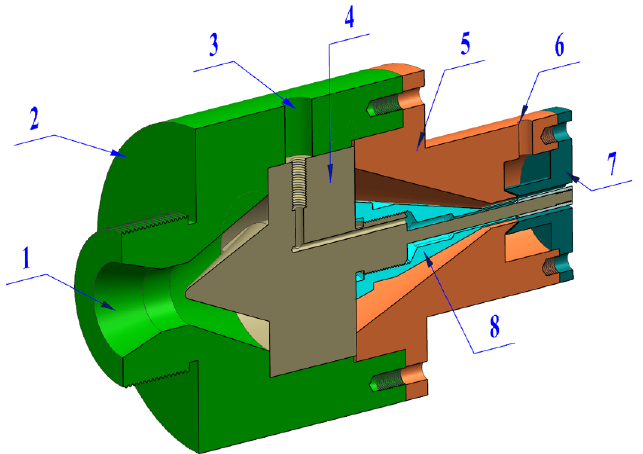
Figure 10. Schematic diagram of the extrusion die. 1—Inlet of melt; 2—Extruder connection module; 3—Inlet of inner gas cushion layer; 4—Front part of the diverter cone; 5—Die connection module; 6—Inlet of outer gas cushion layer; 7—Die; 8—End part of the diverter cone.